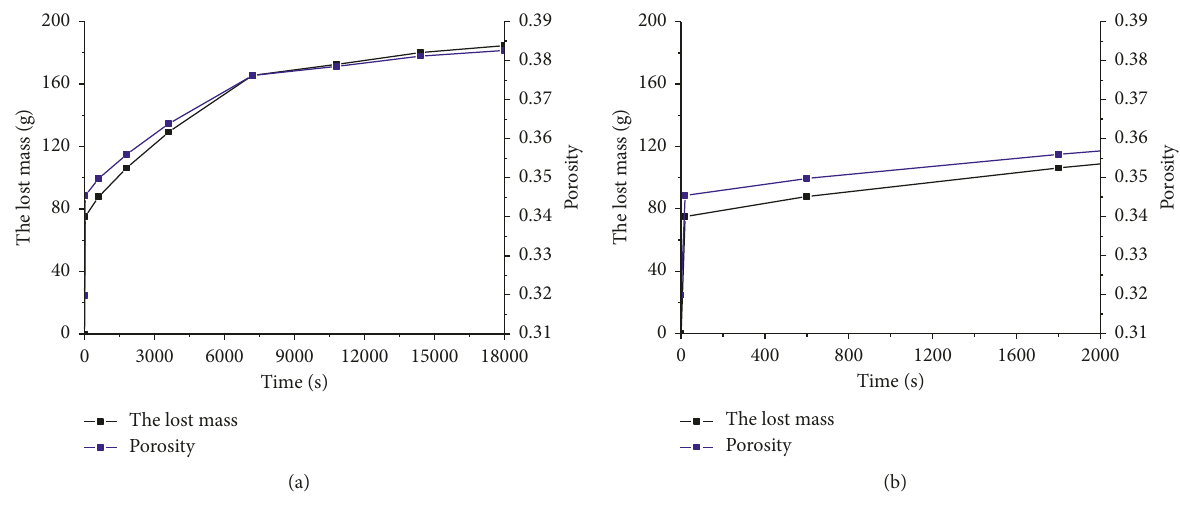
Figure 13: The time-varying rules of the lost mass and